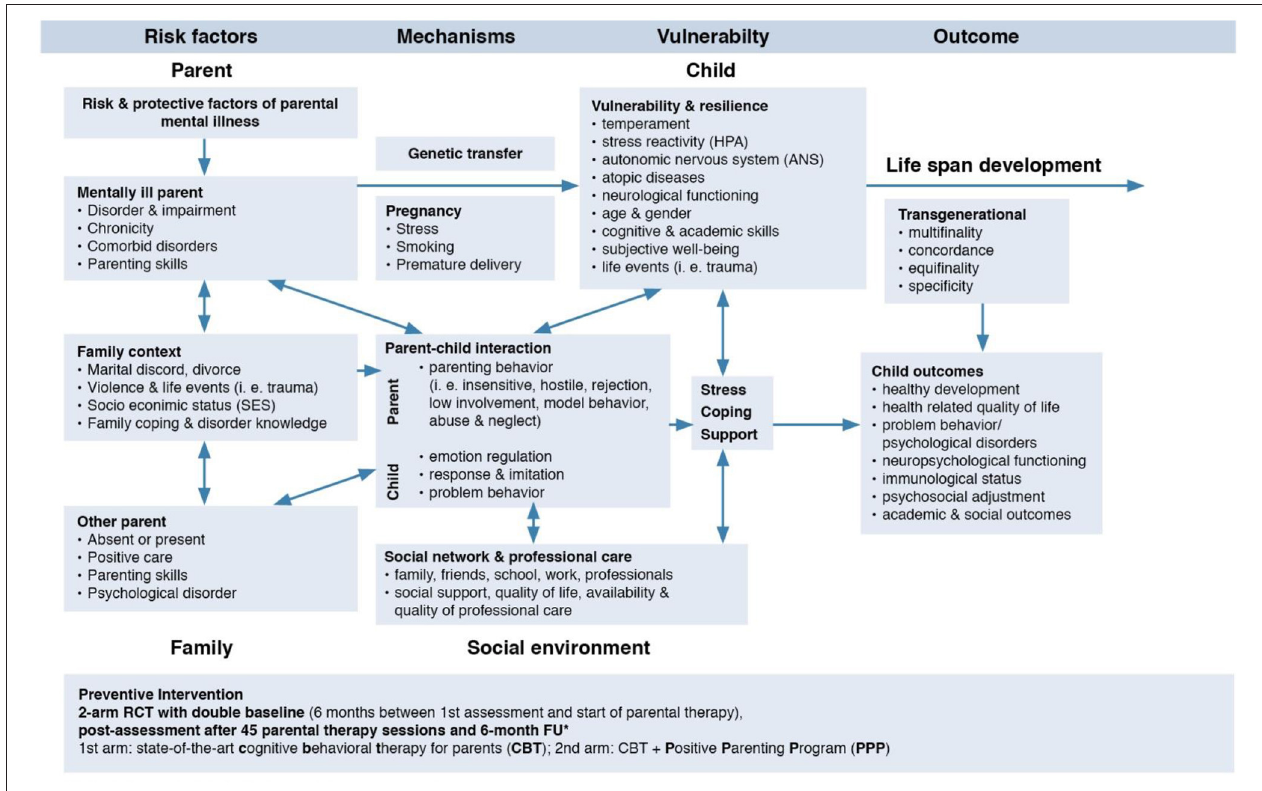
FIGURE 1 | Model of the trans-generational transmission of mental disorders adapted from Hosman et al. (14), p. 253, identifying risk factors, mechanisms, vulnerability, and child outcome. The influence of interventions on the different aspects of the model is an inclusion of the